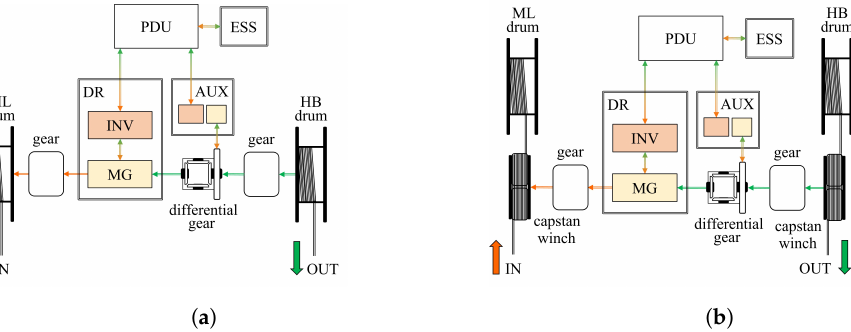
Figure 9. Alternative TY drivetrain concepts. ( a ) TY drivetrain setup and energy flow hauling in with a single power drive and mechanical drum coupling. ( b ) TY drivetrain setup and energy flow hauling in with a single power drive, mechanical drum coupling, and capstan